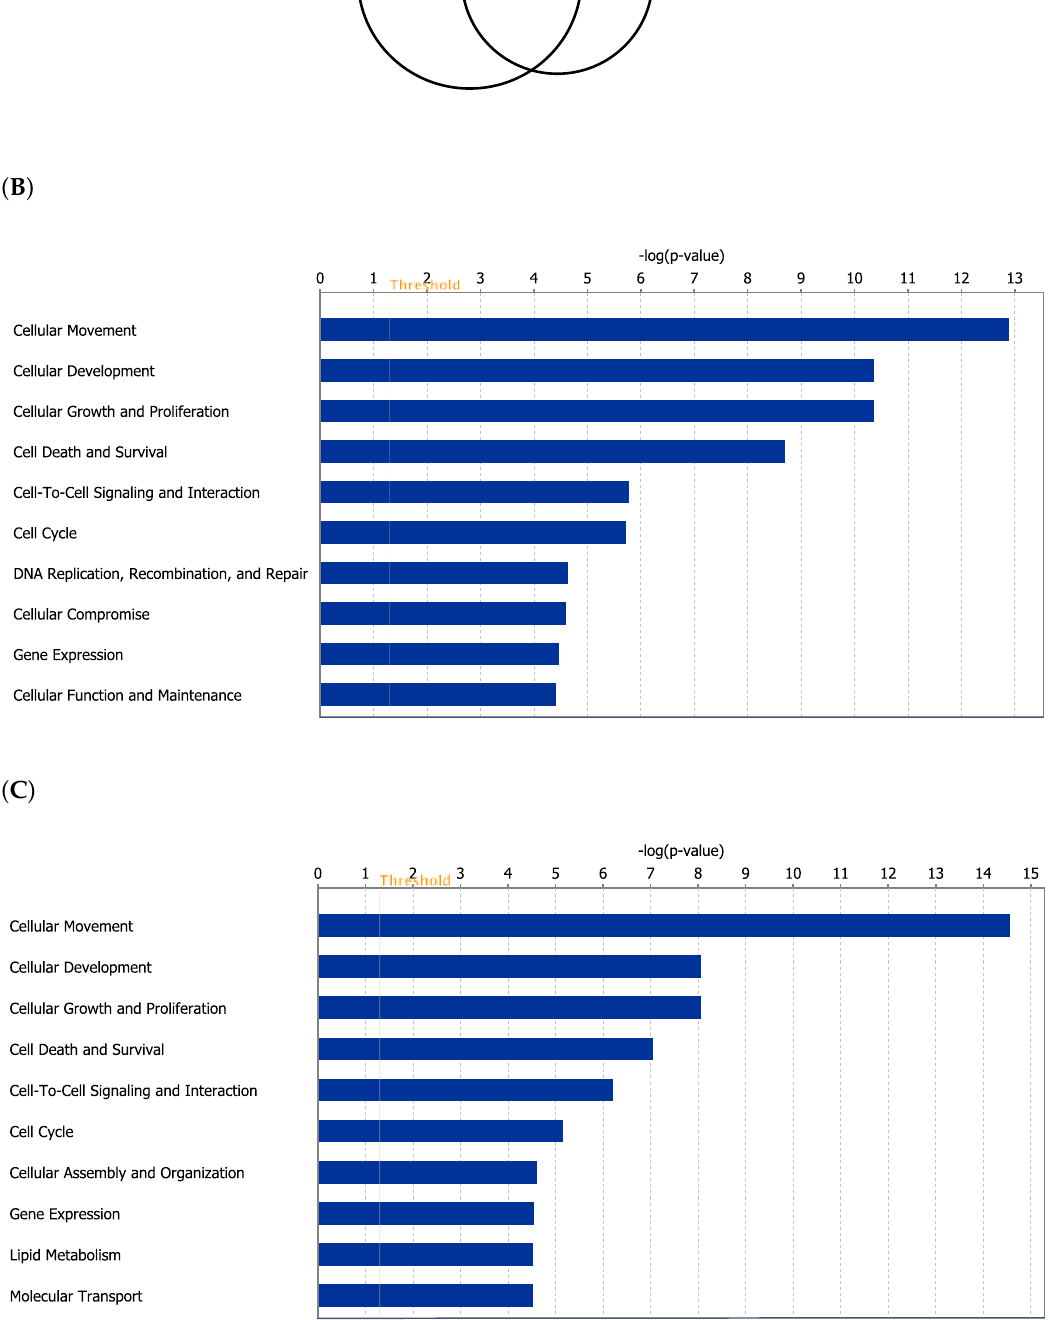
Figure 5. Comparison of ∆ ECv and Differentially Expressed Genes (DEG). ( A ) Venn diagram for the genes extracted by ∆ ECv and DEG. ( B ) Top 10 terms of the molecular function analysis for the ∆ ECv-extracted 150 genes. ( C ) Top 10 terms of the molecular function analysis for the 125 genes through